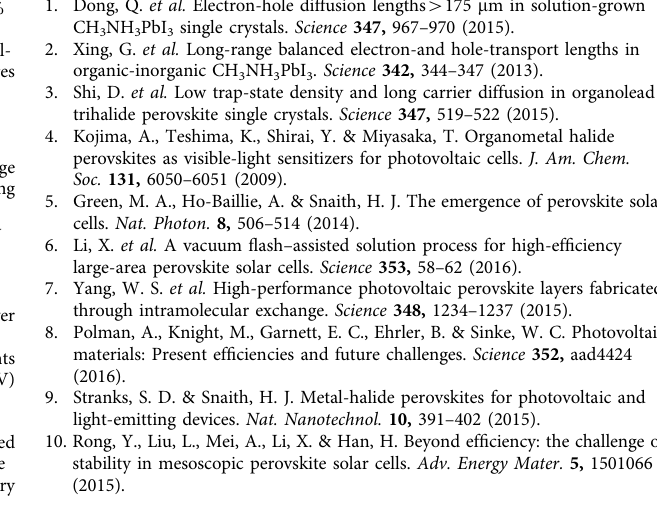
FF, fill factor; PCE, power conversion efficiency; PSC, perovskite solar cell. s.d.’s are calculated from 30 cells for each method. Step-1 for thermal annealing, step-2 for ambient